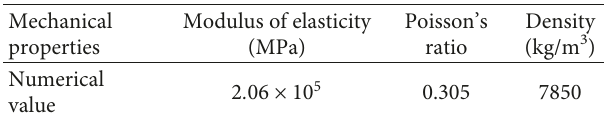
Table 1: Pipe material parameters.